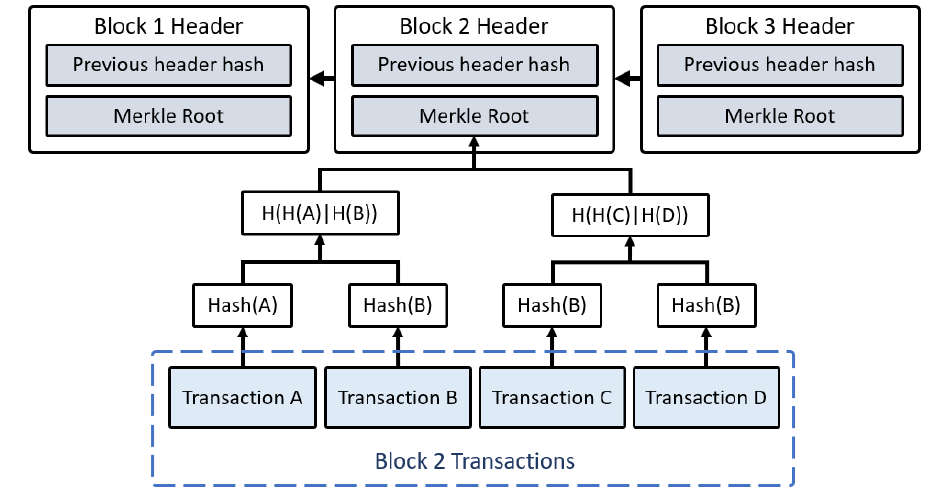
Figure 4. The architecture of Merkle tree in the